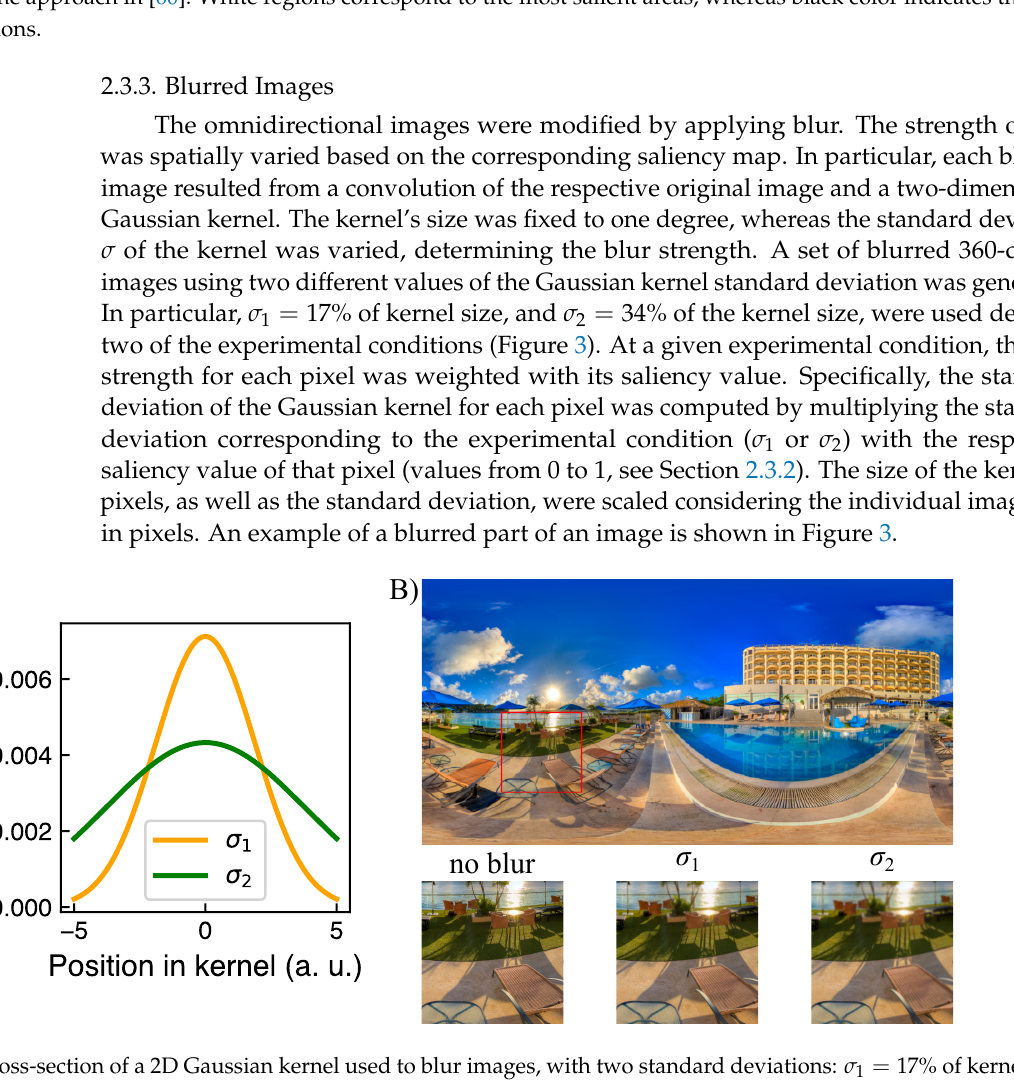
Figure 3. ( A ) A cross-section of a 2D Gaussian kernel used to blur images, with two standard deviations: σ 1 = 17% of kernel size, and σ 2 = 34% of the kernel size. The kernel size was fixed to a number of pixels corresponding to 1° visual angle. For schematic illustration, the kernel size in the plot equals 10 a. u. ( B ) Example of blurred part of one scene generated as a convolution of respective 2D Gaussian kernel and original image, considering its saliency map. In the lower row of ( B ), a part of the original image which is indicated by a red rectangular is shown in three blur conditions: no blur, Gaussian blur with maximum standard deviation σ 1 , and Gaussian blur with maximum standard deviation σ 2